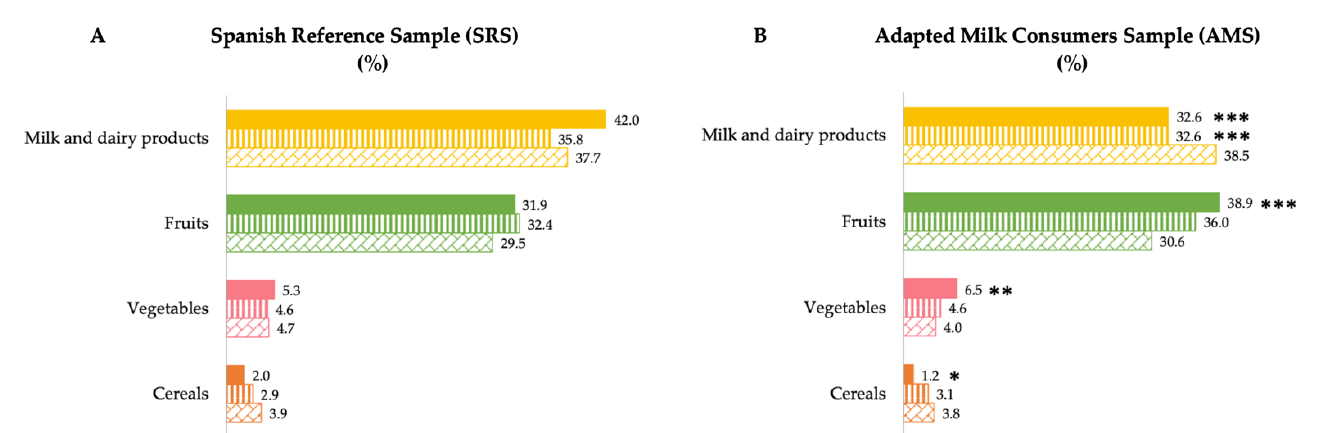
Figure 1. Dietary food and beverage groups contributing to intrinsic sugar intakes (%) from the EsNuPI study population (“Spanish Pediatric Population”) in both the Spanish Reference Sample ( A ) and the Adapted Milk Consumers Sample ( B ). ** p ≤ 0.01 compared to reference sample (Mann–Whitney test); *** p ≤ 0.001 compared to reference sample (Mann–Whitney test). Only foods contributing ≥ 1% to total intrinsic sugar intakes of the population have been included.